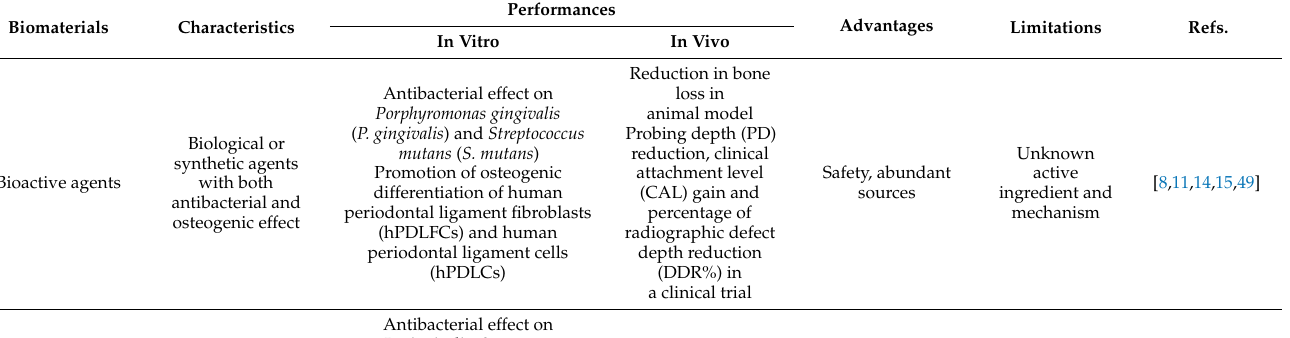
Table 1. The summary of periodontal